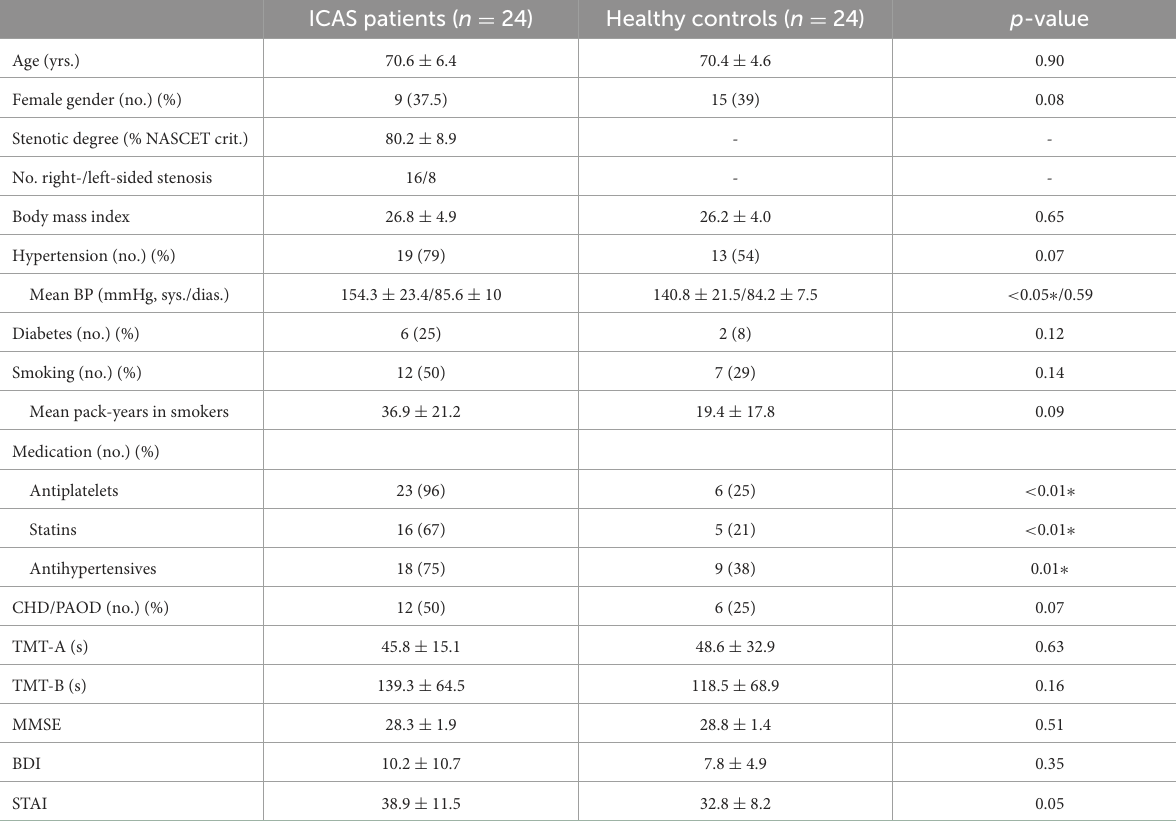
TABLE 2 Clinical characteristics of ICAS patients and healthy controls.